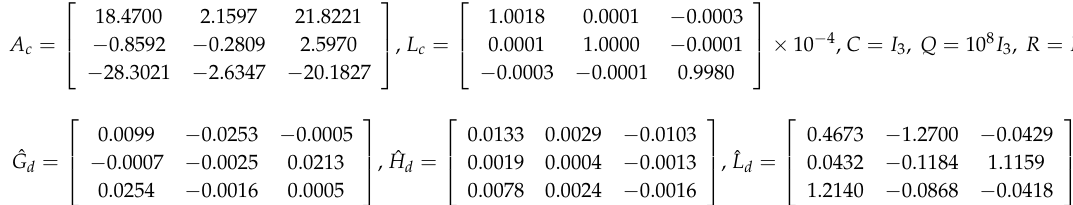
Figure 7. ( a ) Trajectories of